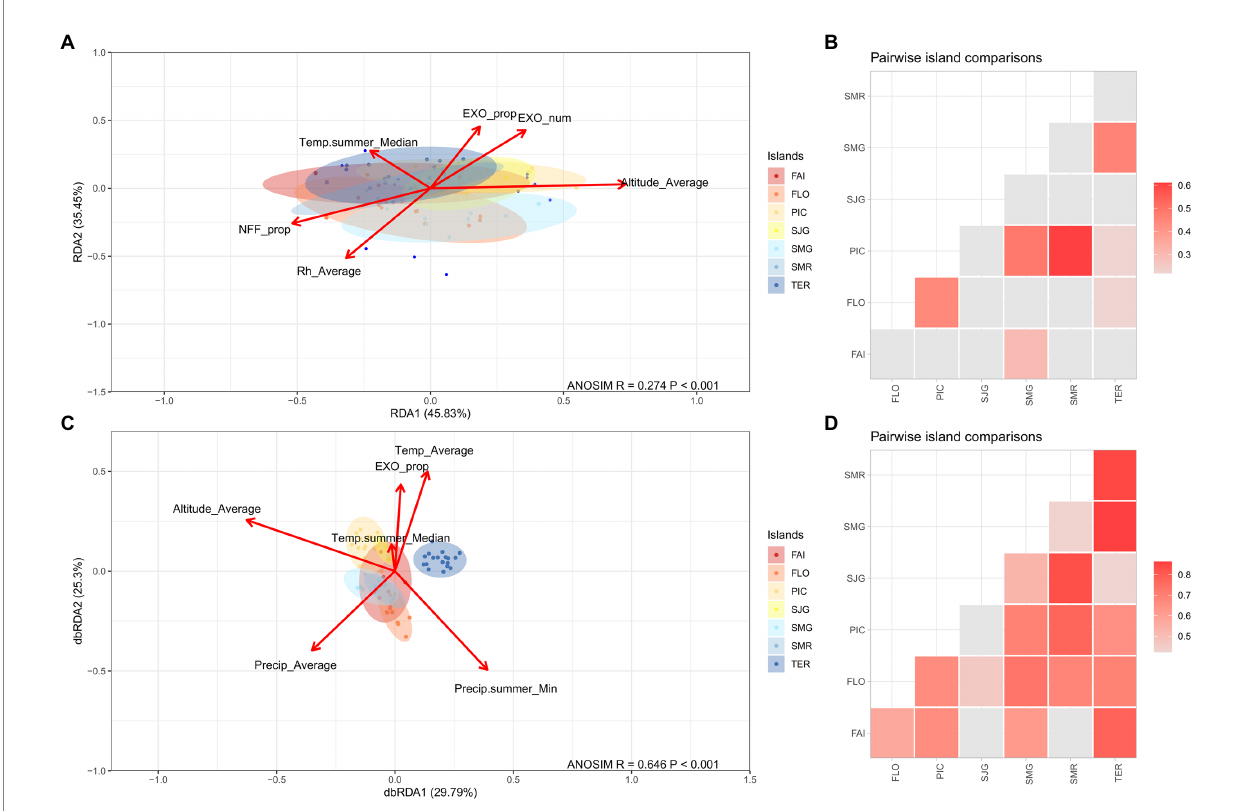
FIGURE 3 The ordination and pairwise ANOSIM comparison of the island subnetworks based on their network properties ( A,B , respectively) and their species pair community ( C , D ,